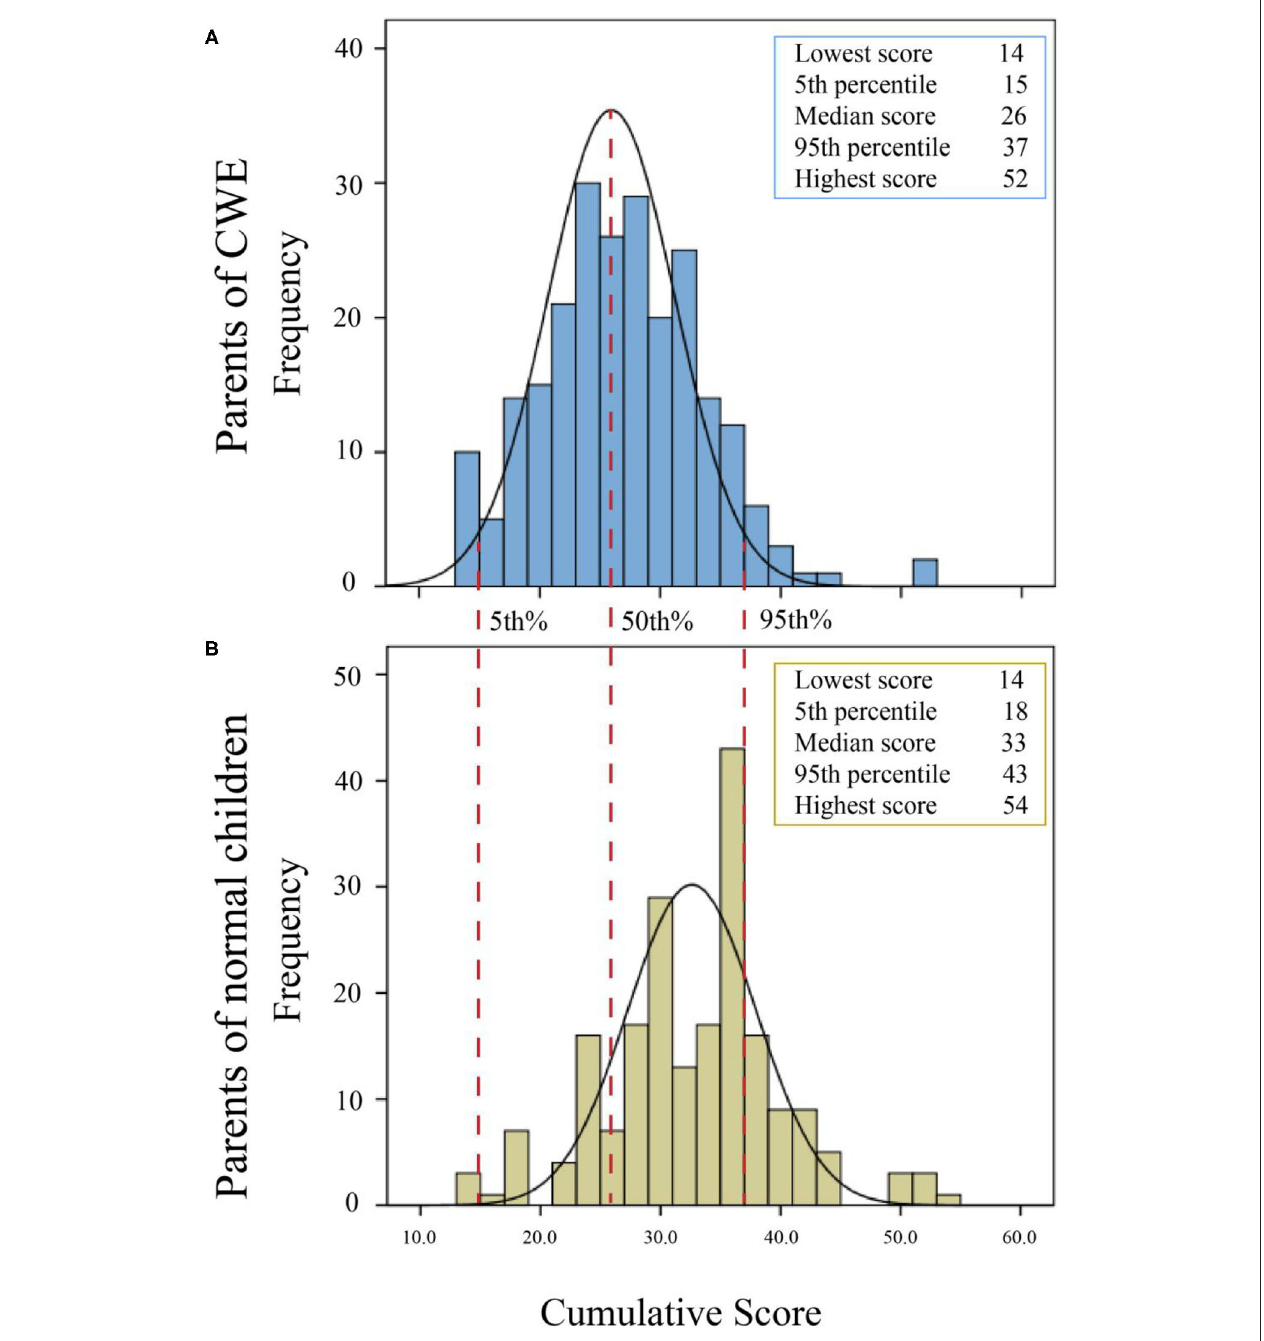
FIGURE 1 | Trend in attitude toward epilepsy presenting in cumulative score histograms of parents of children with epilepsy (CWE) ( A , blue blocks) and normal children ( B , yellow blocks). Cumulative score is shown in the x-axis, and the frequency of cumulative score is shown in the y-axis. The black smooth curves represent the normal distribution of the two groups. Three red vertical dotted lines represent the 5th, 50th, and 95th percentiles of distribution of parents of children with epilepsy and how they project on the distribution of parents of normal children.